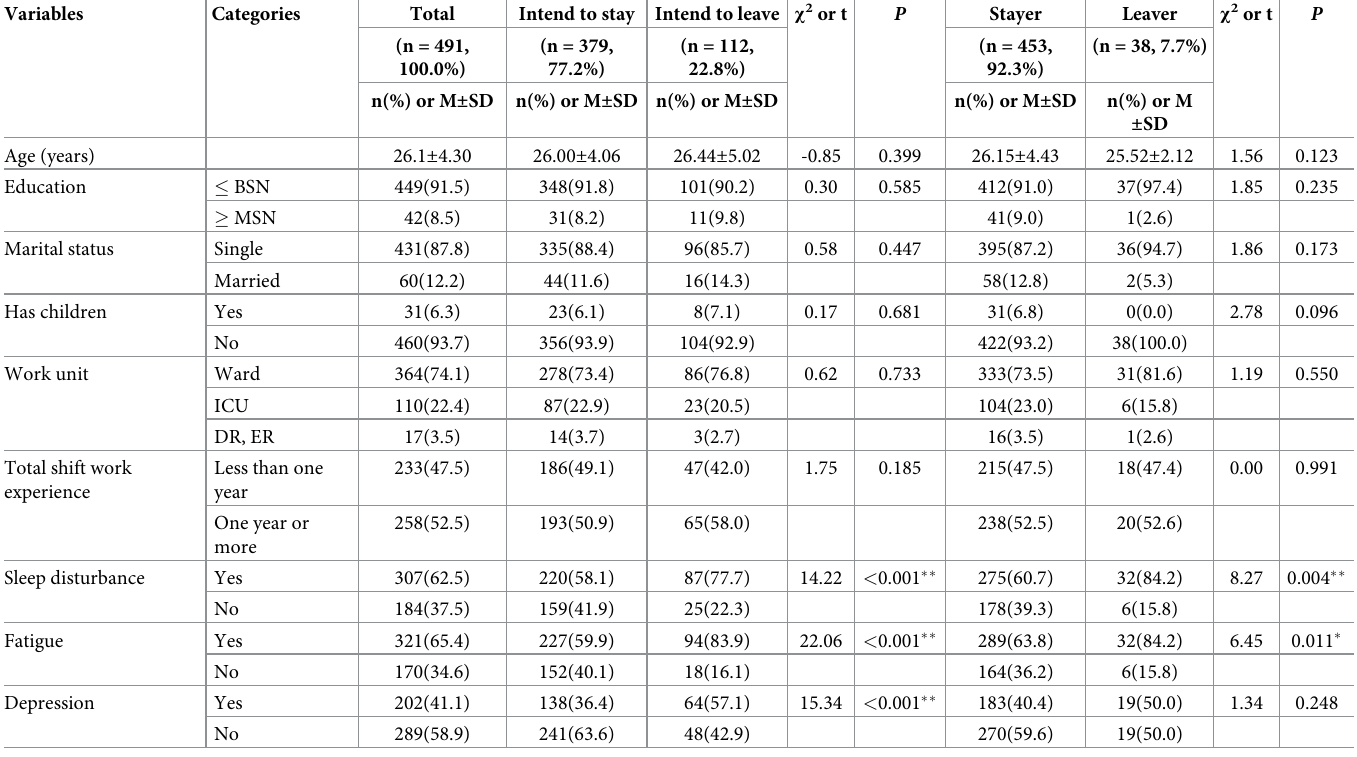
turnover According to the multiple logistic regression analysis with covariates, sleep disturbance, fatigue, and depression were each associated with turnover intention (Table 2). Moreover, Table 1. General characteristics and health problems by turnover intention and actual turnover.